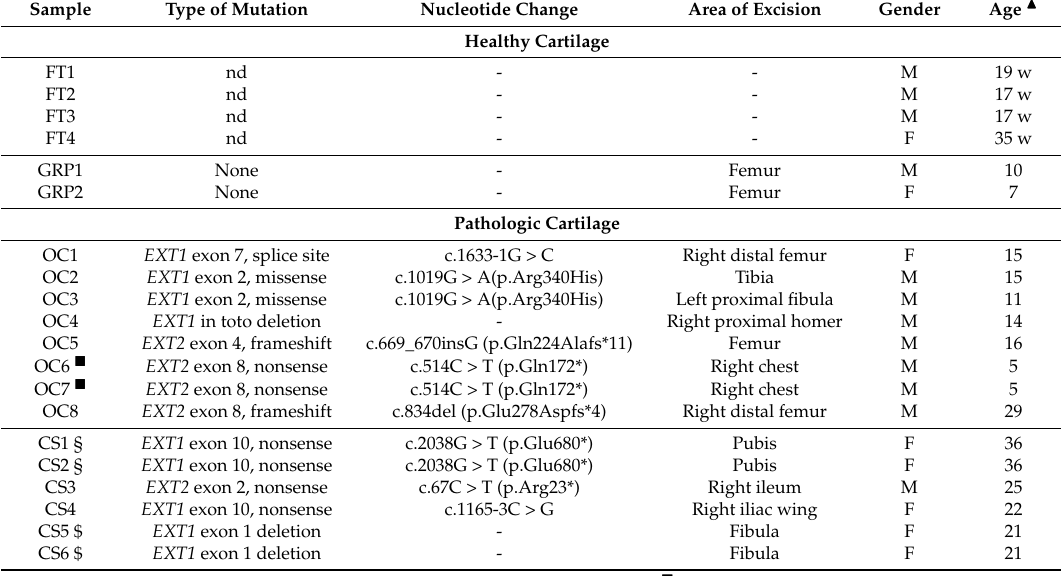
Table 1. List of healthy and pathologic samples. Information on patients (gender, and age at resection), type of mutation, and area of excision are reported. Amount of starting wet cartilage: about 100 mg for prepubescent growth plate (GRP), and 150–200 mg for all other samples. FT—fetal growth plate; OC—osteochondromas; CS—chondrosarcomas; nd—not detected; EXT—exostosin gene; F—female;